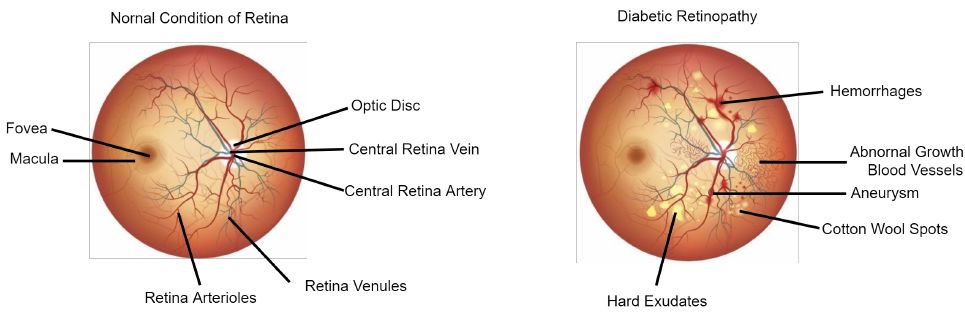
Figure 1. Illustration of the entire retina image. The fundus image on the left depicts the normal retina condition, and the fundus image on the right depicts a retina with diabetic retinopathy symptoms.